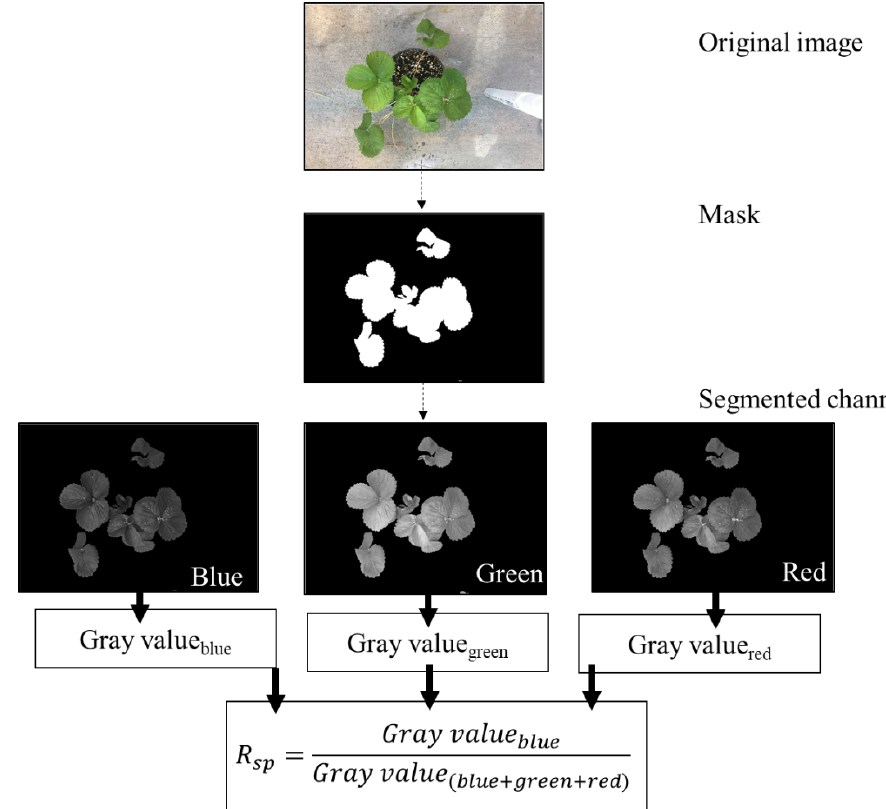
Figure 2. Procedure for the estimation of N stress index by a smartphone (R sp ). Strawberry plant images are shown in the illustration. The green channel of the original image was enhanced to make mask, blue, green, and red channels were separated, and the mask was used to segment plants in three channels. Average gray values were calculated for each segmented channel to estimate R sp .